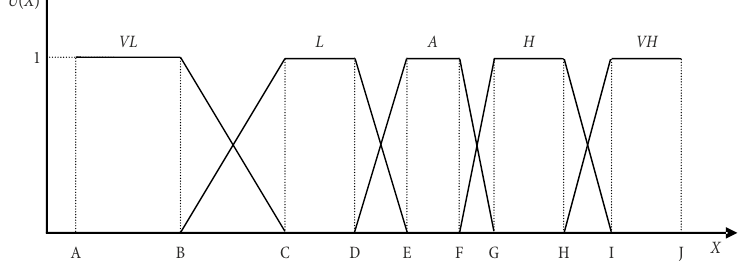
Fig. 1. The trapezoidal representation of the five linguistic terms ( VL , L , A , H , VH ) for a generic variable